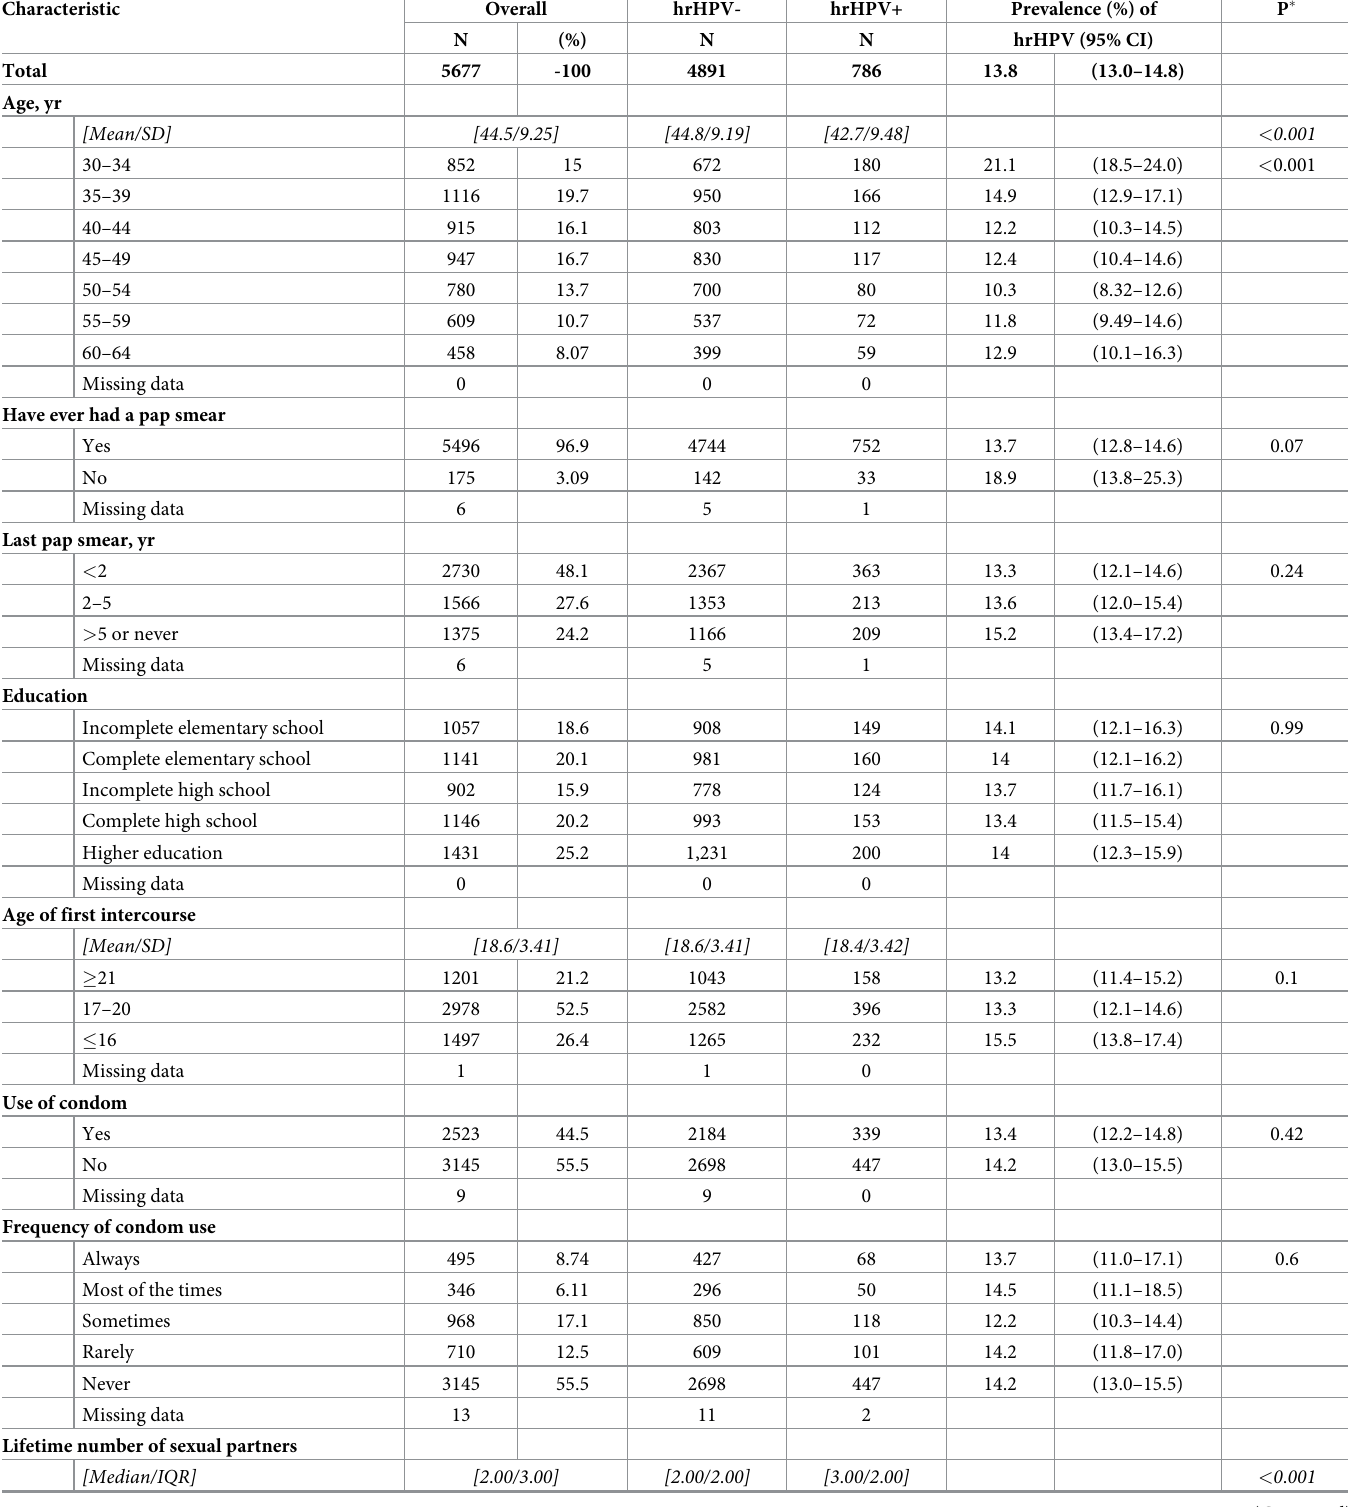
Table 1. Characteristics and prevalence of hrHPV in 30-69-year-old women from the Central Department Paraguay.